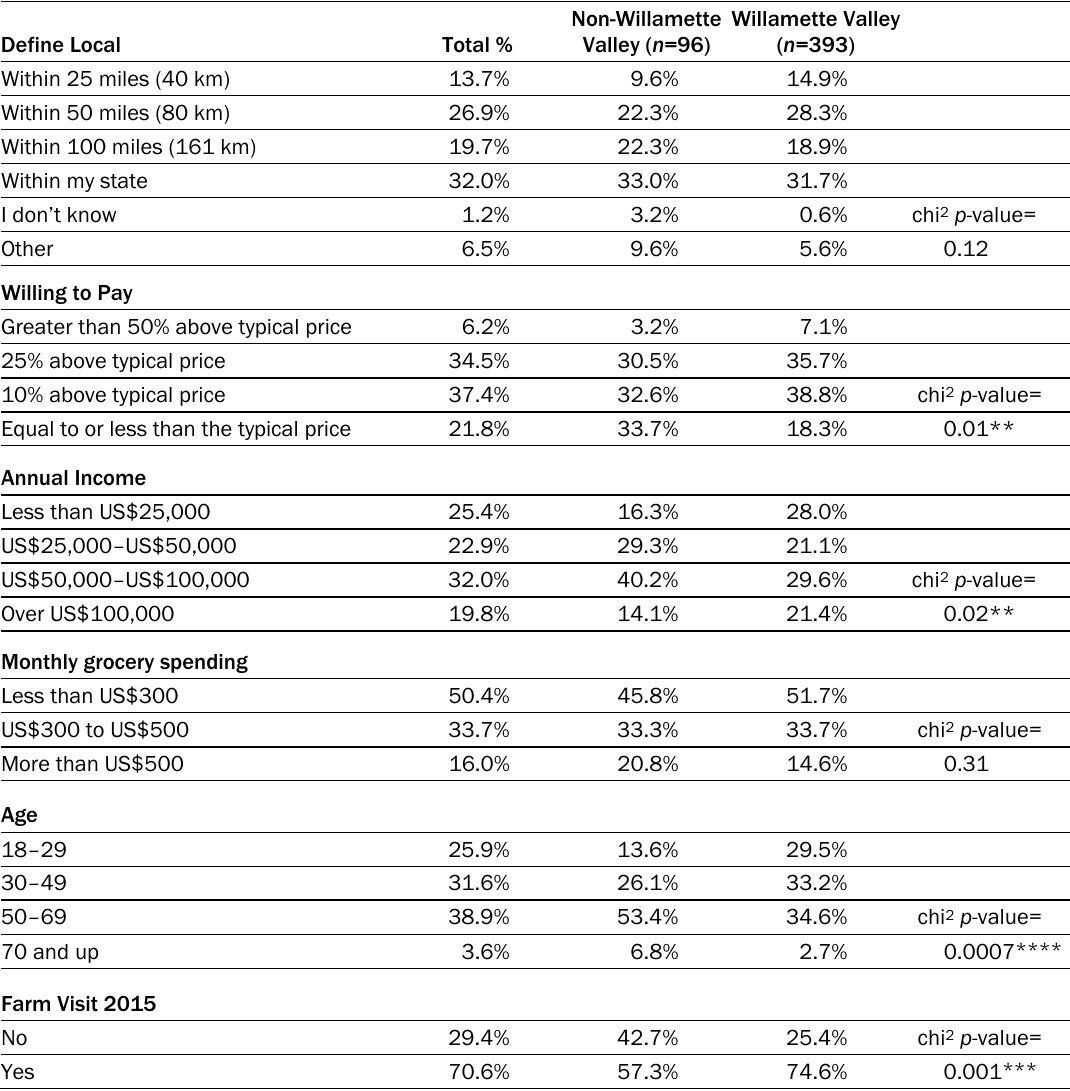
Table B3: Non–Willamette Valley and Willamette Valley Consumer Responses, by Consumer Attributes (all income in